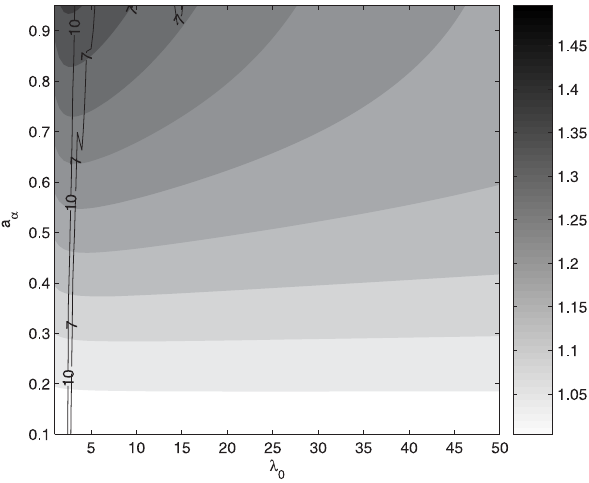
Fig. 4. Sensitivity of the return period ratio R ( AM ) λ 0 and a α , with T =100 years, n =1, δ = π and a λ =0.5. In each point of the plane the intensity of the grey-shade is proportional to the value of the return period ratio. The percentage of cases recog- nized as non-Gumbel by the Anderson-Darling test (at a 5% level) is indicated by the black (labelled) contour lines. N =50 years is